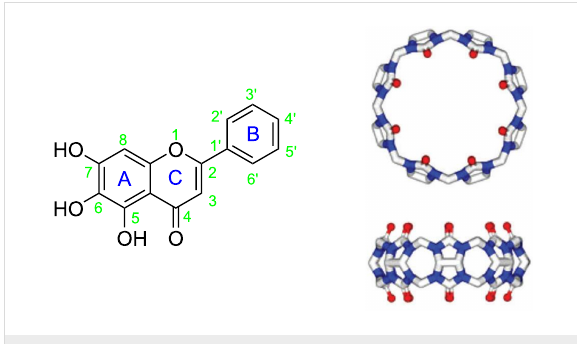
Figure 1: Chemical structures of baicalein (left), cucurbit[8]uril (right).